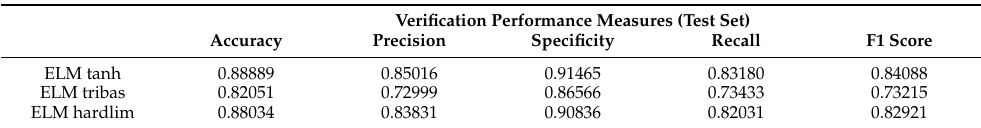
Table 16. Verification (test) classification performance measures of the ELM classifier for three different transfer functions of the ELM algorithm in dataset #3.